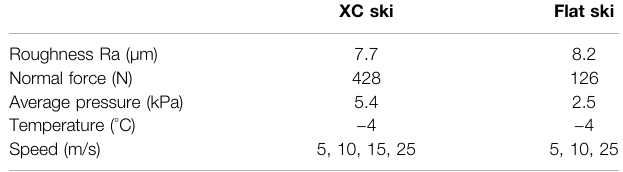
TABLE 1 | Test samples and test